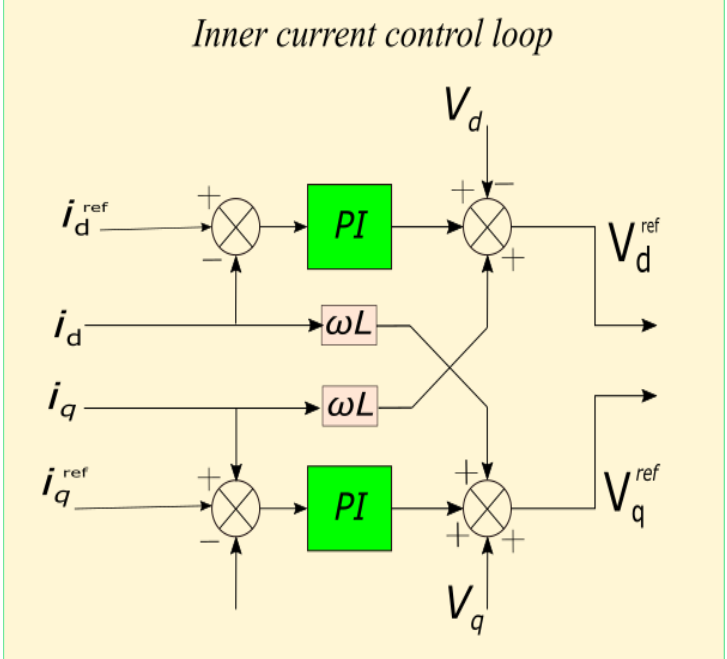
Figure 8. MMC inner current control